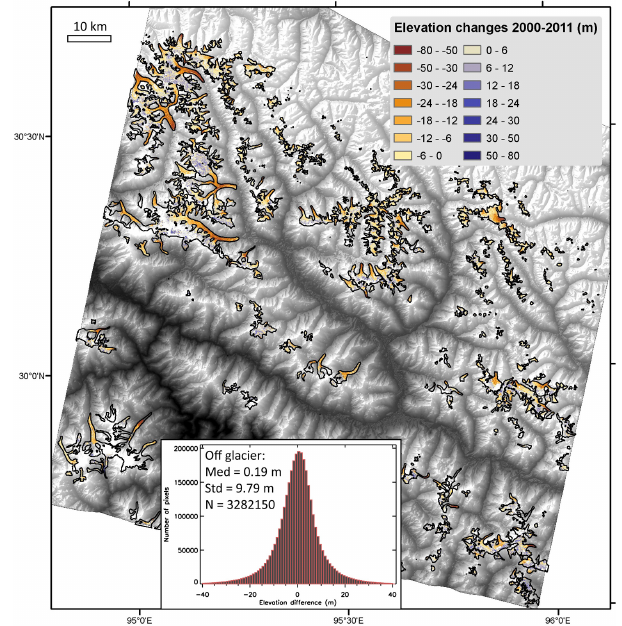
Fig. 2. Glacier elevation changes over the Hengduan Shan study site. Inset: distribution of the elevation differences off glacier. The median and the standard deviation of the elevation difference and the number of pixels off glaciers are given (by construction the mean elevation difference is null).